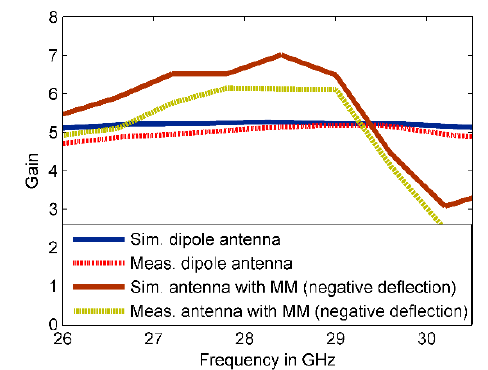
Figure 18. The numerical and experimental gain of the proposed antenna with and without MM array for negative deflection angle at 28 GHz.